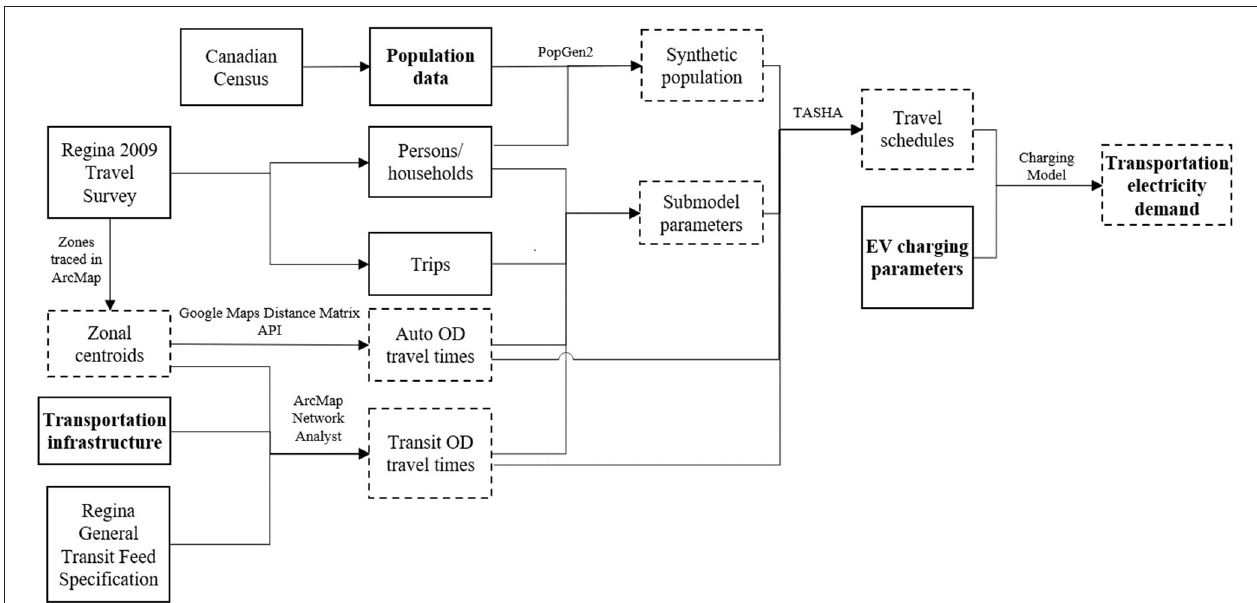
FIGURE 3 | Transportation model processes, with solid boxes representing raw data inputs and dashes boxes representing a processed output. Note that bold text represents a direct tie-in to Figure 2 .